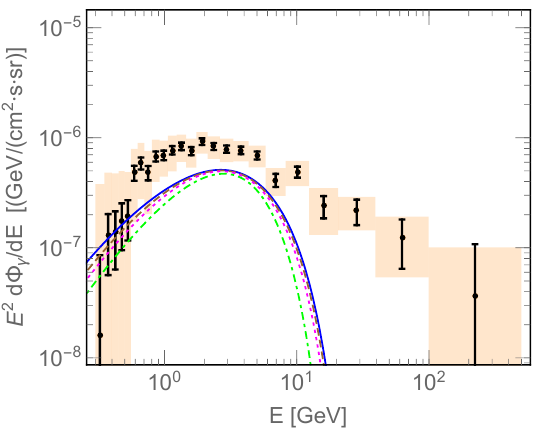
Figure 3 . Comparison of the spectrum of the Galactic Center gamma-ray excess [8] vs. the best-(cid:12)t results for DM annihilating through a two-step cascade to the (cid:12)nal state (cid:28) ’s, where, for the former, the statistical and systematical errors are shown by error bars and orange rectangles, respectively, while for the latter, the solid (blue), dashed (brown), dotted (magenta), and dotdashed (green) curves are for the cases of ( m S ; m A ) = (0 : 5 m X ; 0 : 2 m X ), (0 : 7 m X ; 0 : 3 m X ), (0 : 9 m X ; 0 : 36 m X ), and (0 : 95 m X ; 0 : 45 m X ), respectively, with the corresponding p -values 0.22, 0.22, 0.23, 0.12. The corresponding good (cid:12)t results, featuring by the p -values, are shown in the plane of m X and low- velocity annihilation cross section in (cid:12)gure